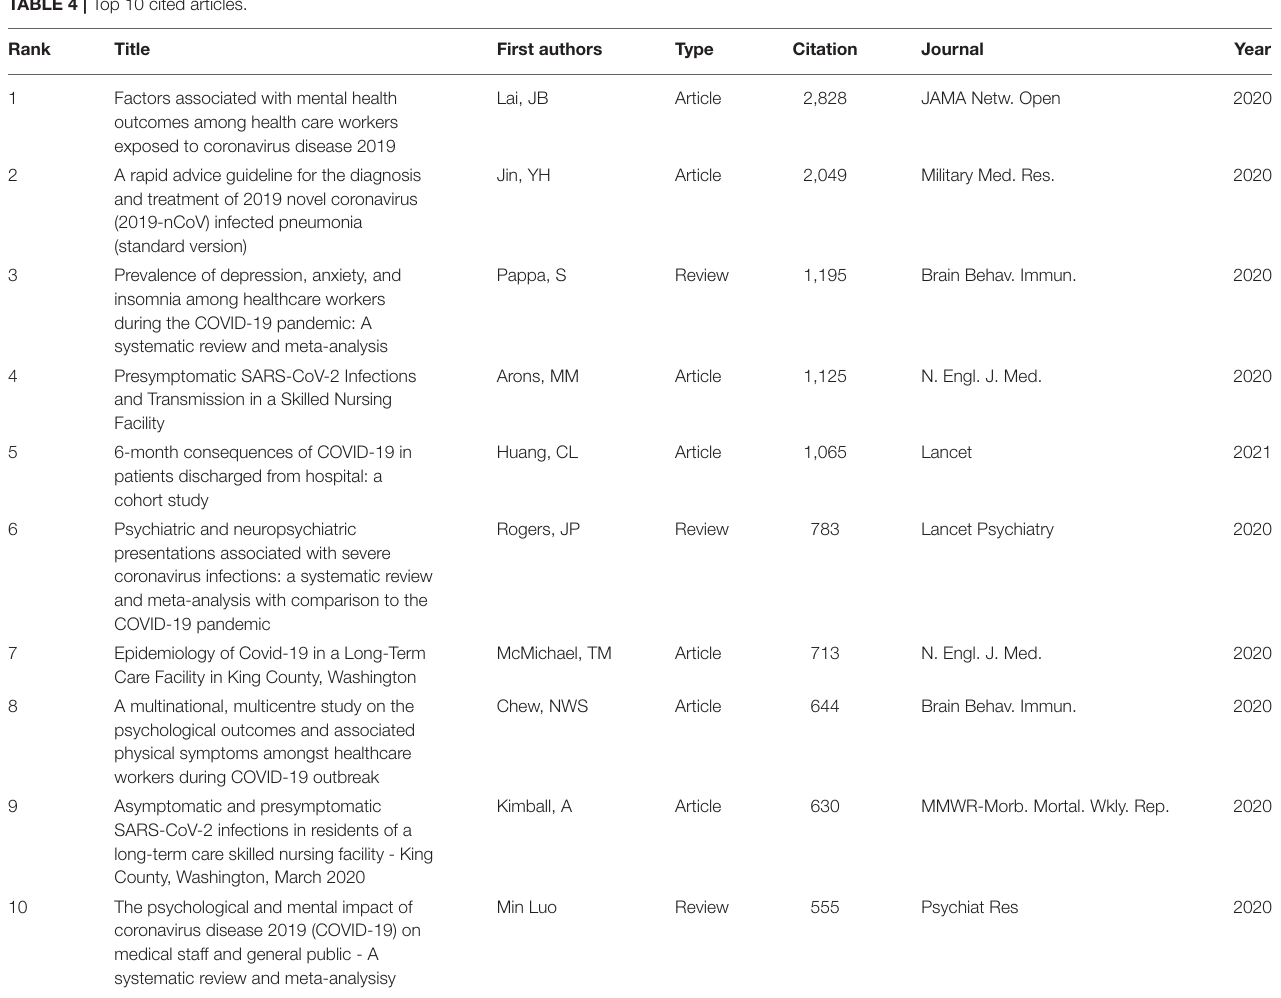
TABLE 4 | Top 10 cited articles.